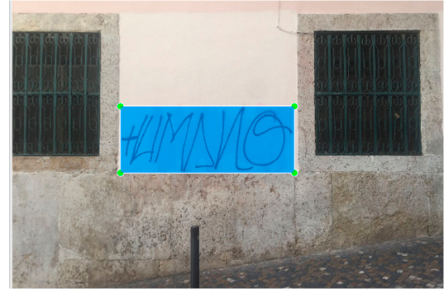
Figure 10. Example of a labeled image.